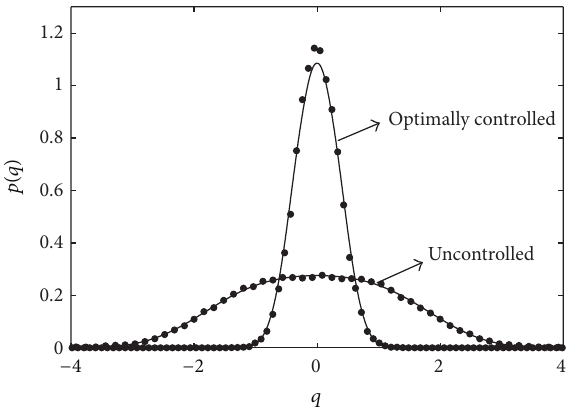
Figure 2: Stationary probability density 𝑝(𝑞) of displacement of uncontrolled and optimally controlled system (28). The lines are obtained from numerical solution of (37) while the dots are obtained from direct simulation of original system (28).